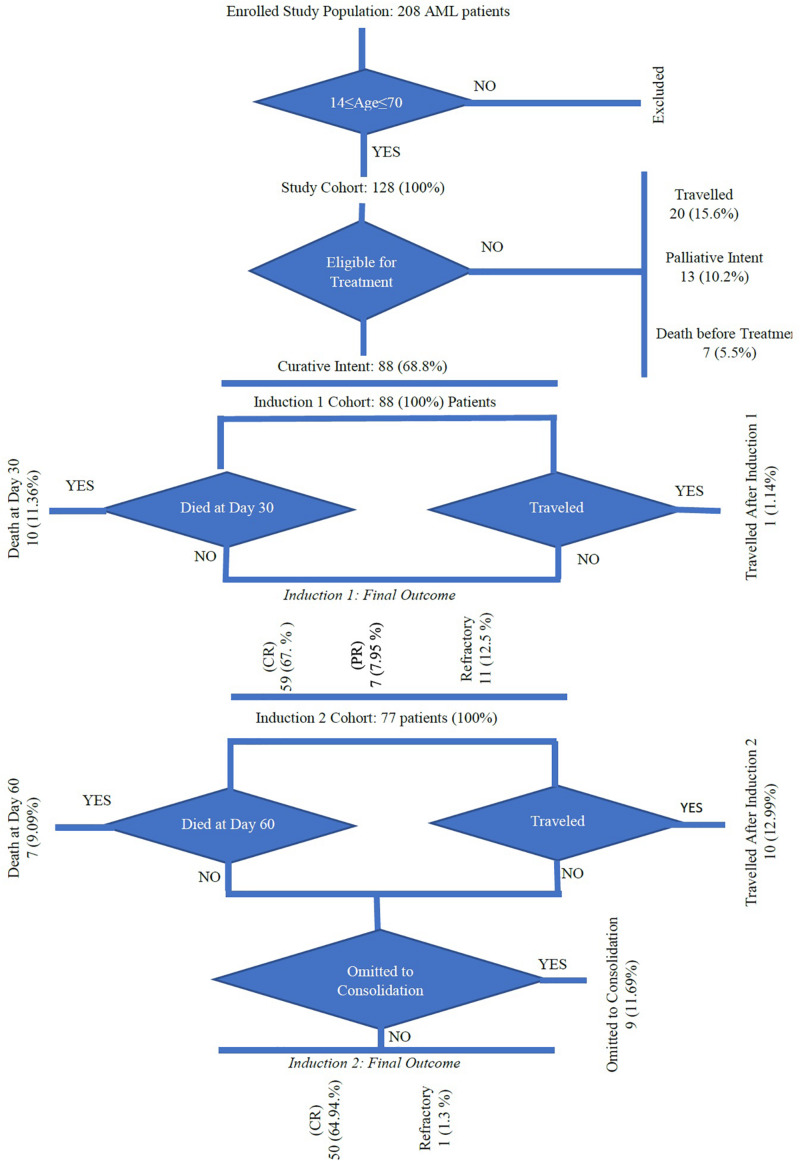
Plan of care summary.